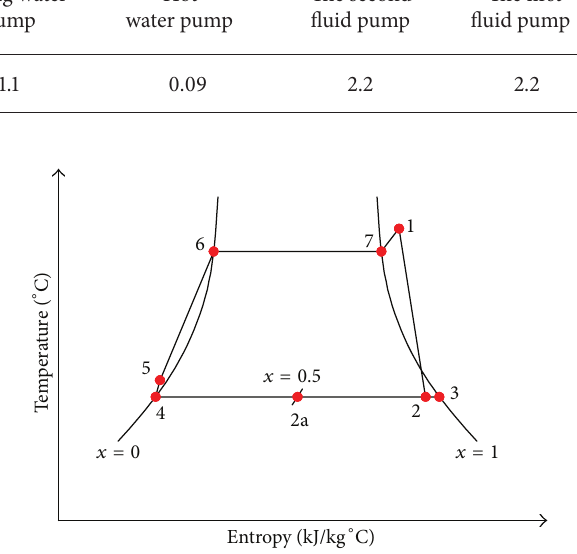
Figure 3: Power cycle of the second fluid